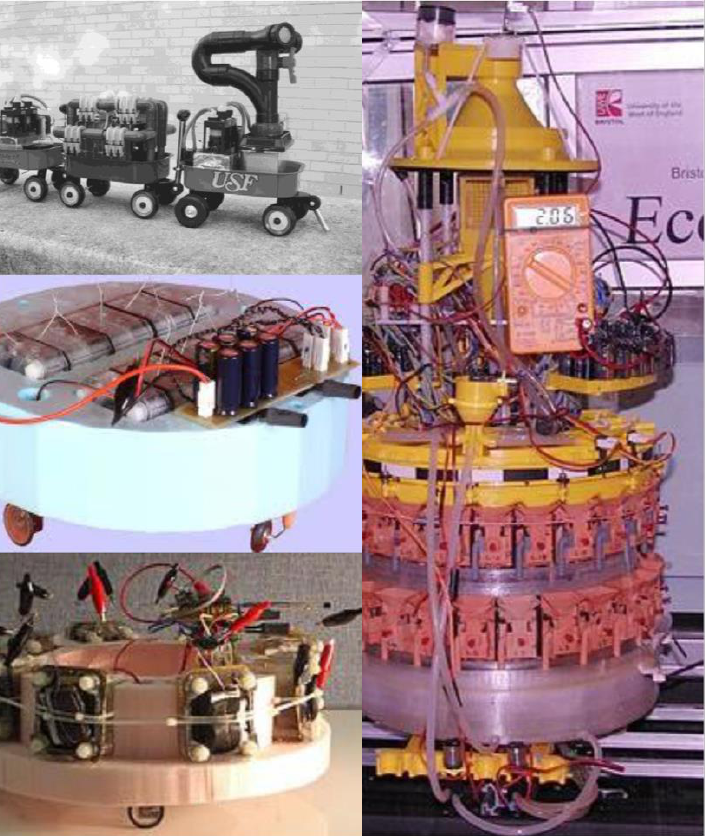
Figure 6. Scaled up construction of MFC ( Α dapted with permission from Ref. [316]).